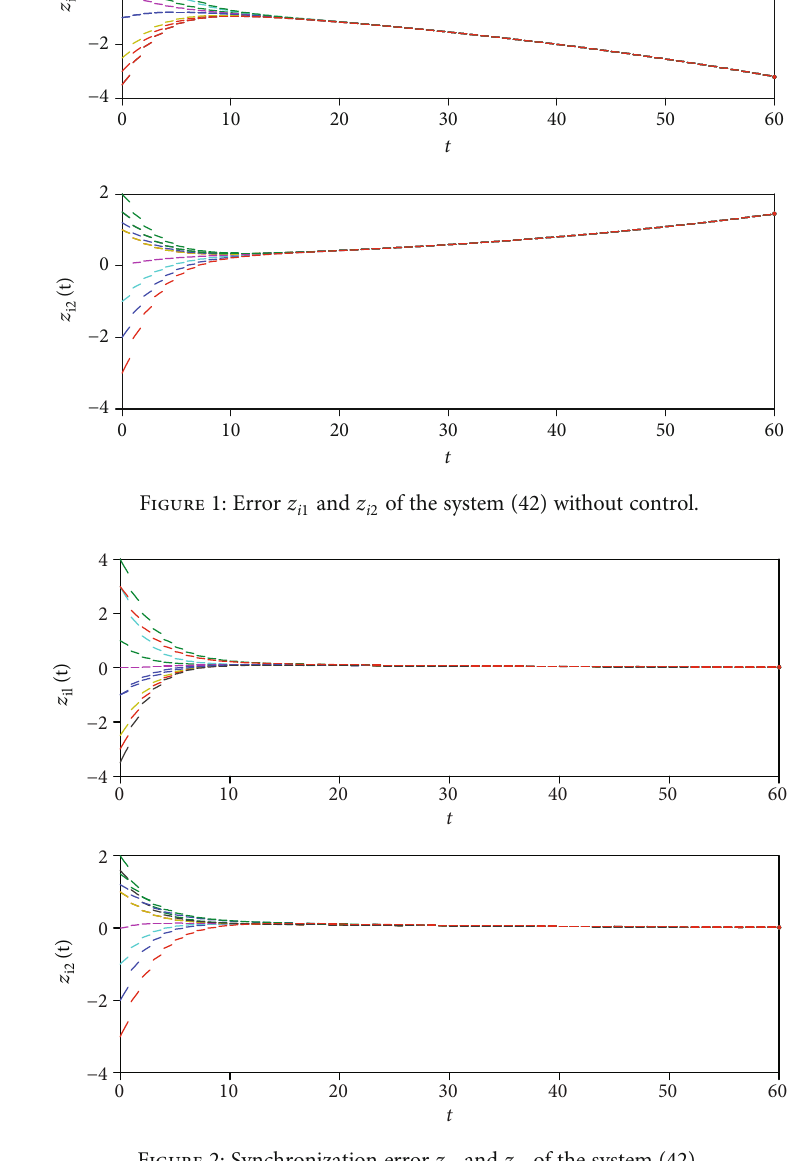
and z of the system i 1 i 2